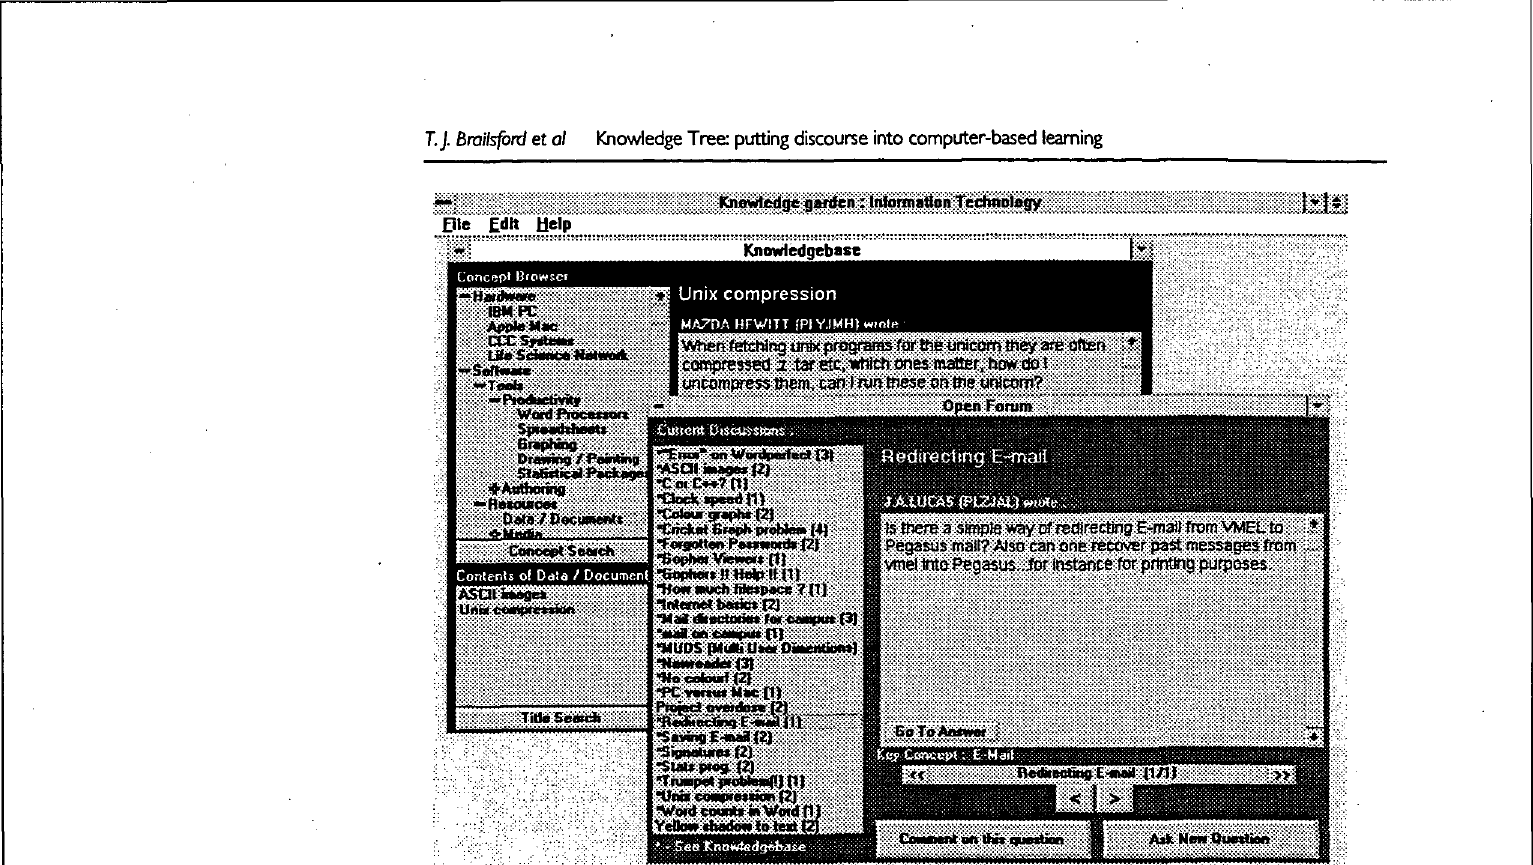
figure 4: Part of the Forum from an Information Tedino/og/ knowledge